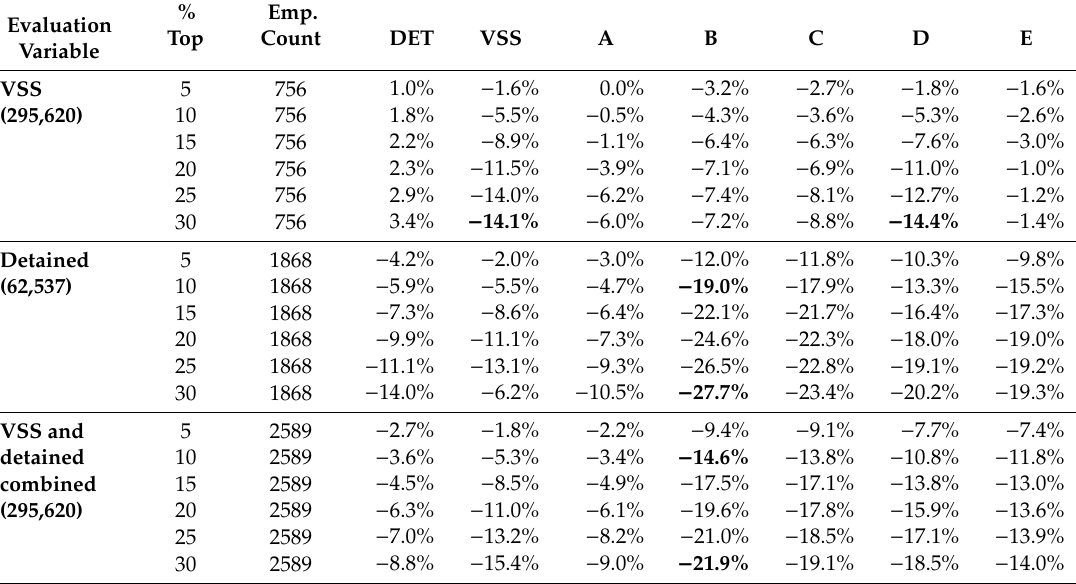
Table 5. Reduction in false negatives compared to random selection (top 5% to top 30% of vessels).